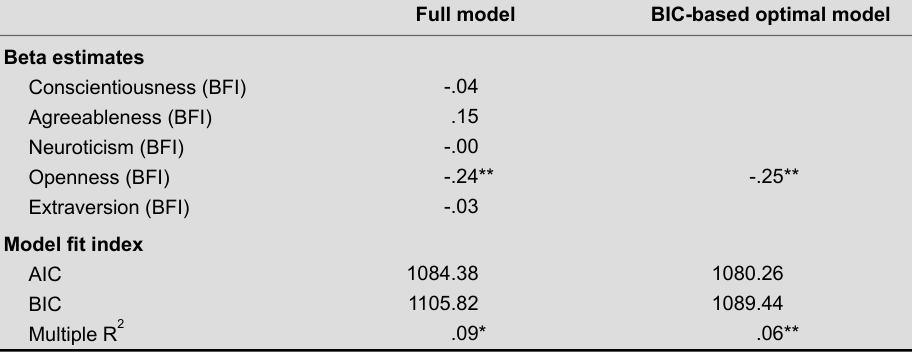
BIC-based optimal modelFull